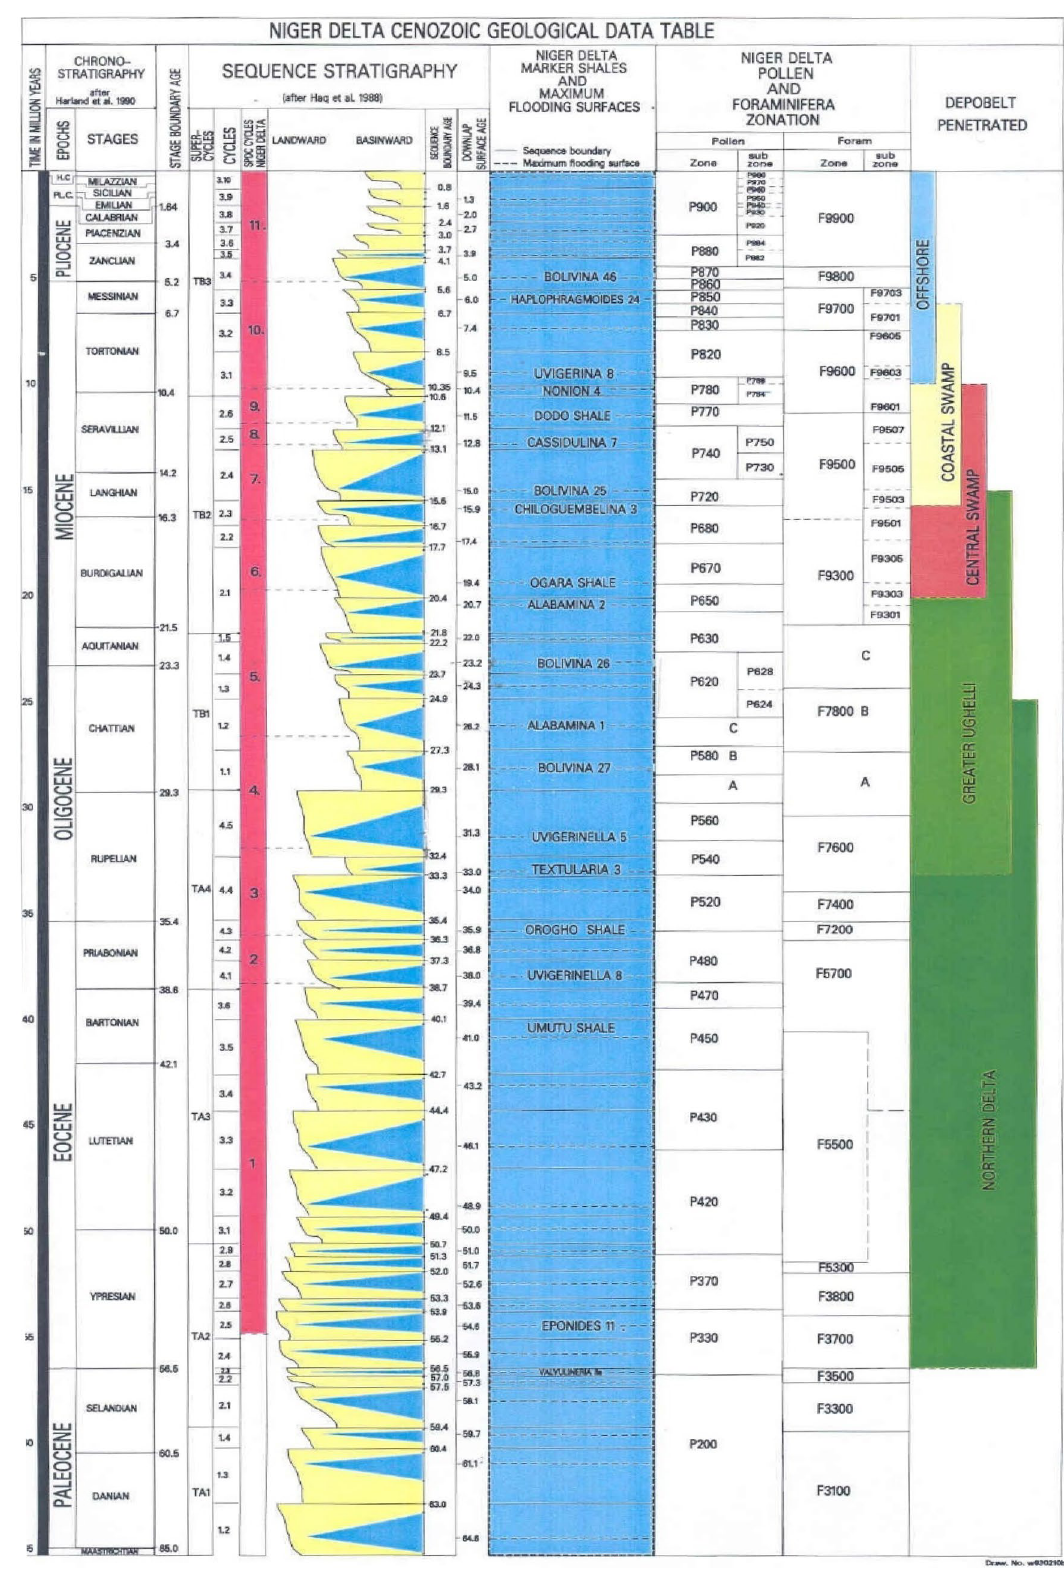
Fig. 2 Shell Niger Delta Chronostratigraphic Chart used for calibration of biostratigraphic